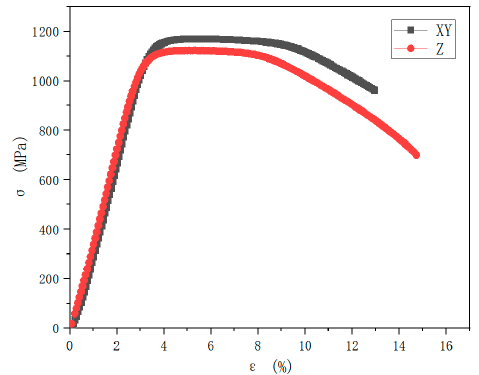
Figure 8. The engineering stress–strain curve of the SLM specimen.